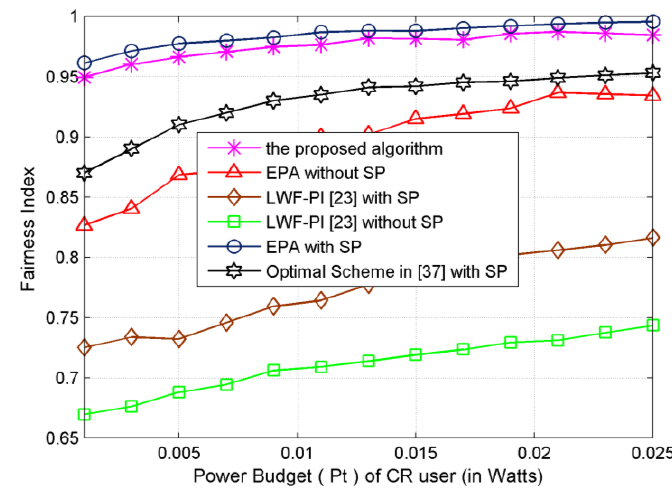
Figure 6. Power Budget versus Fairness